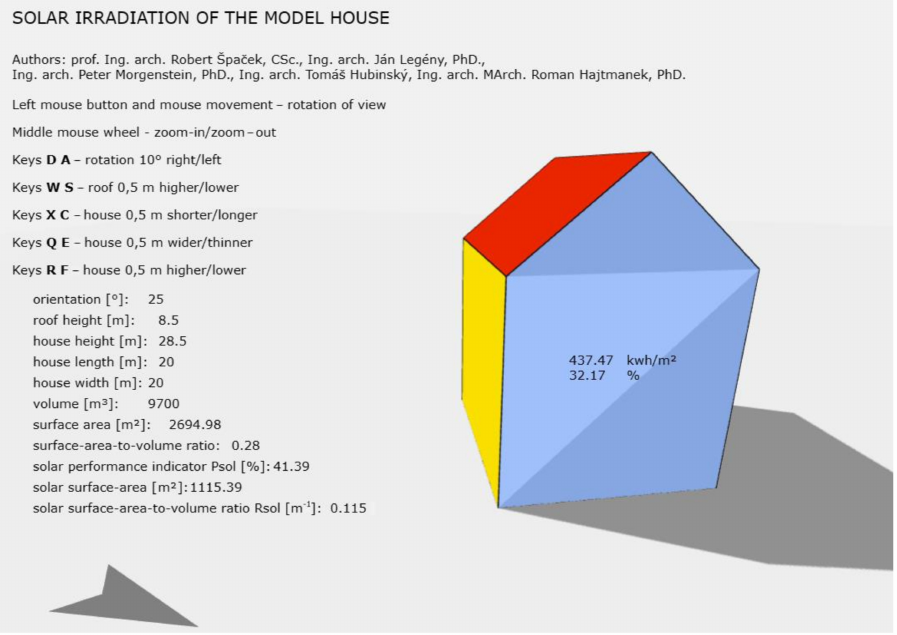
Figure 4. Web application solarmodel.hajtmanek.sk for visualisation of solar potential and indicators.